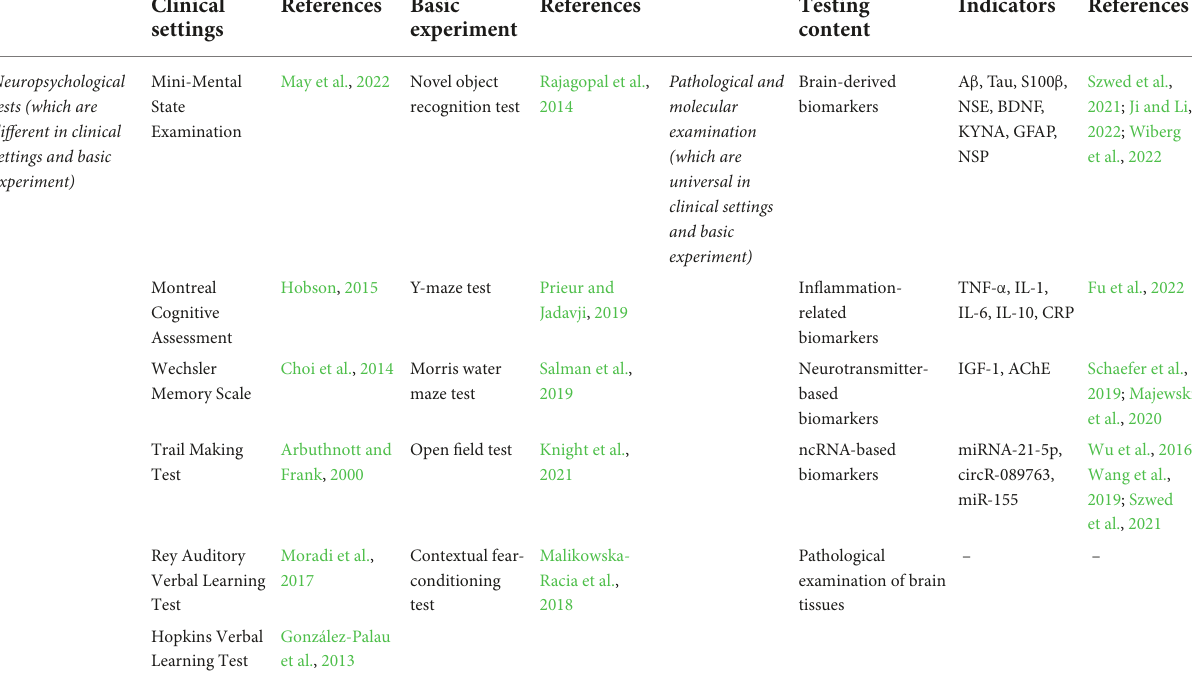
TABLE 1 The frequently used diagnosis methods for